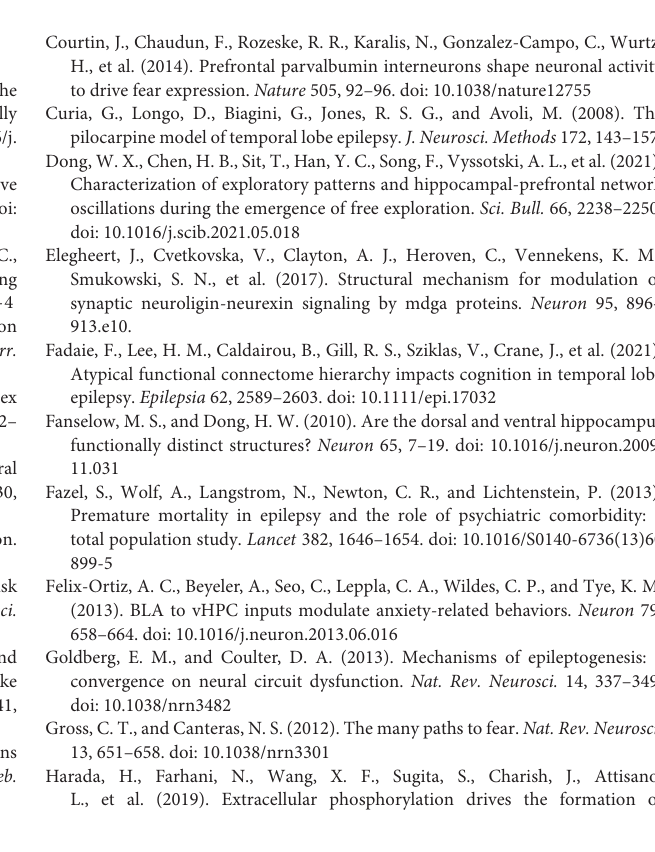
Supplementary Figure 1 | Neuronal classification and activity responses. (A) HPC neurons ( n = 180 neurons from 5 mice) were classified by valley-to-peak time and spike half-width when the mice entered the food zone; blue, putative GABAergic neurons; red, putative glutamatergic neurons; (B) Quantified neuronal responses to approach-RA, where blue hollow rectangle = no response GABAergic neurons, red hollow rectangle = no response glutamatergic neurons, blue triangle = approach-RA excited GABAergic neurons, red triangle = approach-RA excited glutamatergic neurons, blue circle = approach-RA inhibited GABAergic neurons, and red circle = approach-RA inhibited glutamatergic neurons; and (C) Representative raster plots and waveforms of